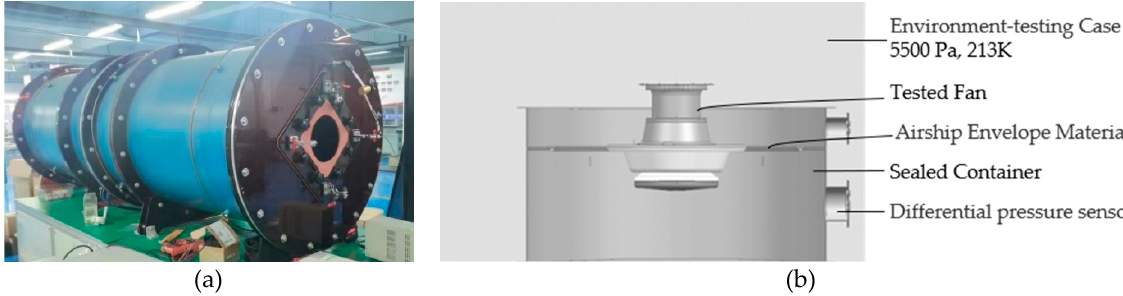
Figure 10. ( a ) Fan performance test bench for the ground condition; ( b ) Fan performance test bench for stratospheric